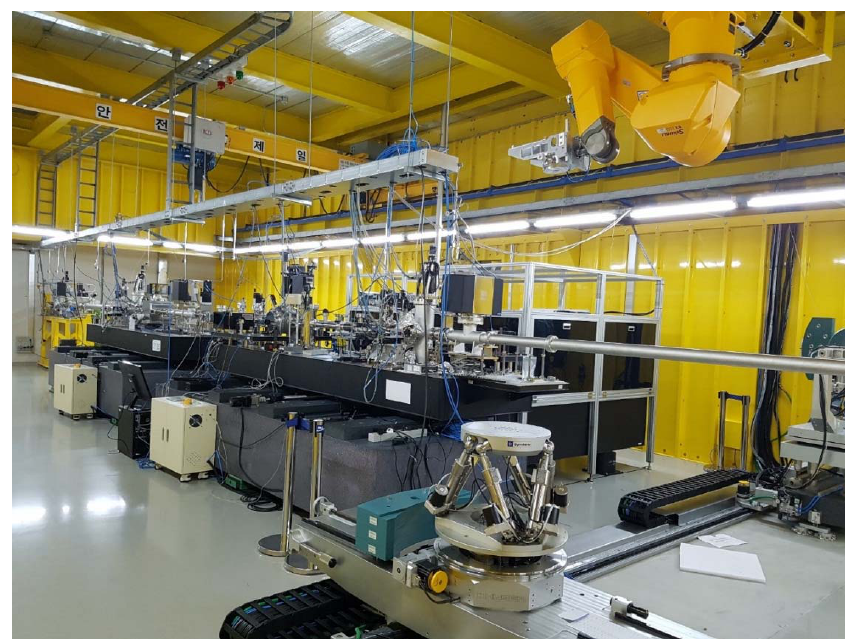
Figure 6. Inside view of HEH1.